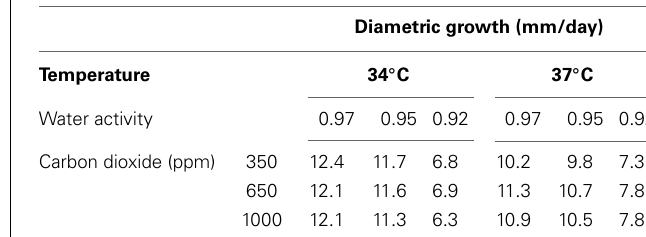
Table 2 | Comparison of growth of Aspergillus flavus under different interacting conditions of elevated temperature, drought stress, and elevated CO 2 in vitro on a conductive yeast-glucose medium (adapted from Medina et al., in